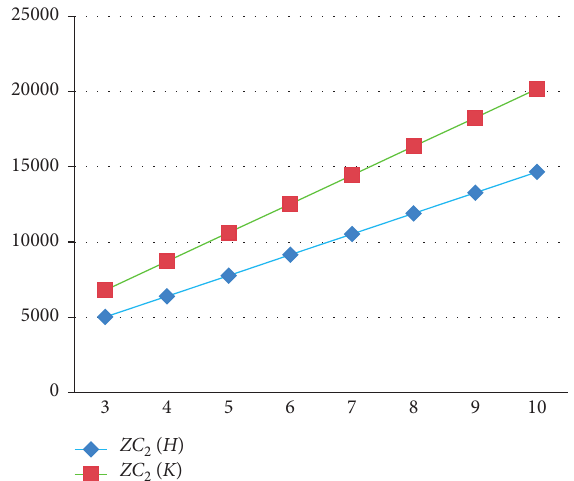
index for H and K networks on 2